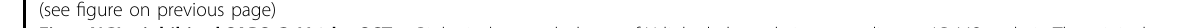
Fig. 1 NGI-1 inhibited SARS-CoV-2 by OST. a Biological network cluster of N-linked glycosylation according to AP-MS analysis. The original score of identi fi ed host proteins interacting with viral proteins was indicated by color scale within the circle. Score > 200 indicated suf fi cient con fi dence. n.d., not detected. The pie chart was divided into 5 slices, representing 3a, E, M, S and N proteins of SARS-CoV-2, respectively. The network was delivered according to STRING website (https://string-db.org/). Network in the gray shaded area showed OST complex. b 3× Flag-Twin-Strep tagged E, M or S proteins of SARS-CoV-2 were overexpressed in HEK293T. Proteins were pulled down after ultrasonication and eluted for further PNGase F treatment. Immunoblot analysis of virus proteins with Flag antibody. c Myc-STT3A and 3× Flag-Twin-Strep tagged 3a, E, M or S proteins of SARS-CoV-2 were overexpressed in HEK293T cells, followed by Twin-Strep pull-down. STT3A was analyzed with Myc antibody and viral proteins were analyzed with Flag antibody. The anti-GAPDH blots indicated loading of lanes. d STT3A or STT3B was knocked down in Caco2 cells for 3 days, followed by 3-day-SARS- CoV-2 infection (MOI = 0.01). The supernatant was collected to detect the SARS-CoV-2 gRNA by real-time quantitative polymerase chain reaction (RT- qPCR). The cells were collected to detect mRNA levels of STT3A or STT3B by quantitative polymerase chain reaction (qPCR) ( GAPDH as a reference gene). NC, negative control. e STT3A or STT3B was knocked out by 3 different sgRNAs respectively in HeLa cells stably expressing human ACE2 (HeLa- ACE2). After 3-day-infection, SARS-CoV-2 in the supernatant was analyzed by RT-qPCR. f , g 3× Flag-tagged spike of SARS-CoV-2 was overexpressed in HEK293T cells, followed by 5 μ M NGI-1 treatment for 2 days. Whole cell lysates were collected for Immunoblot analysis ( f ). Spike proteins were pulled down after ultrasonication and eluted for further MS ( g ). Spike was analyzed with Flag antibody. The anti-GAPDH blots indicated loading of lanes. The percentage of spike of the indicated sites, N1074 and N1194, was analyzed by Thermo Scienti fi c Q Exactive ™ Hybrid Quadrupole-Orbitrap ™ Mass Spectrometer. Data are means ± SD, from triplicates (technical replicates). h , i Caco2 cells were infected with SARS-CoV-2 (MOI = 0.01) for 1 h, and the medium was replaced by 2% FBS (v/v) DMEM containing 0, 1, or 5 μ M NGI-1 for further 3-day treatment. SARS-CoV-2 in the supernatant was analyzed by RT-qPCR ( i ). Virus in cells was detected by immunoblotting with N protein antibody ( h ). The anti- α -tubulin blots indicated loading of lanes ( h ). j Caco2 cells were infected with SARS-CoV-2 (MOI = 0.01) for 1 h, followed by treatment of NGI-1 at the indicated concentrations for 3 days. Virus in the supernatant was analyzed by RT-qPCR. The IC 50 was calculated by Statistical Package for the Social Sciences (SPSS) and the dose-response curve was fi tted by GraghPad Prism 8. k Caco2 cells were plated in a 96-well plate and cultured in the presence of NGI-1 at indicated concentrations for 3 days. The cytotoxicity was analyzed by CellTiter 96 ® AQueous One Solution Cell Proliferation Assay. The CC 50 was calculated by SPSS and the dose-response curve was fi tted by GraghPad Prism 8. l Caco2 cells were infected with the South Africa variant of SARS-CoV-2 501Y.V2 (MOI = 0.01) for 1 h, followed by treatment of NGI-1 at the indicated concentrations for 3 days. Virus in the supernatant was analyzed by RT-qPCR. Data are means ± SEM, from triplicates (biological replicates), unpaired t -test, * P < 0.05, ** P < 0.01, **** P < 0.0001 ( d , e , i – l